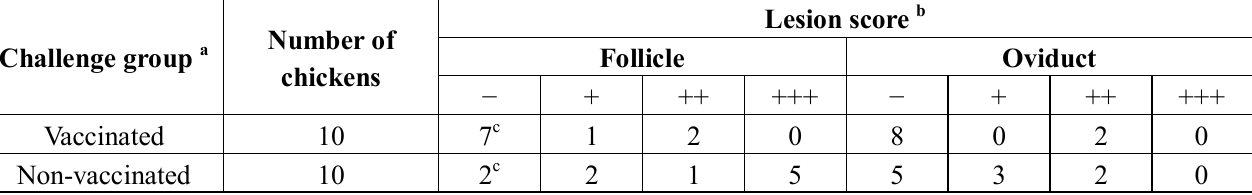
Table 3. Comparison of gross lesions in the ovarian follicles and oviduct between the vaccinated and control chickens at 5 weeks after challenge infection with IBV